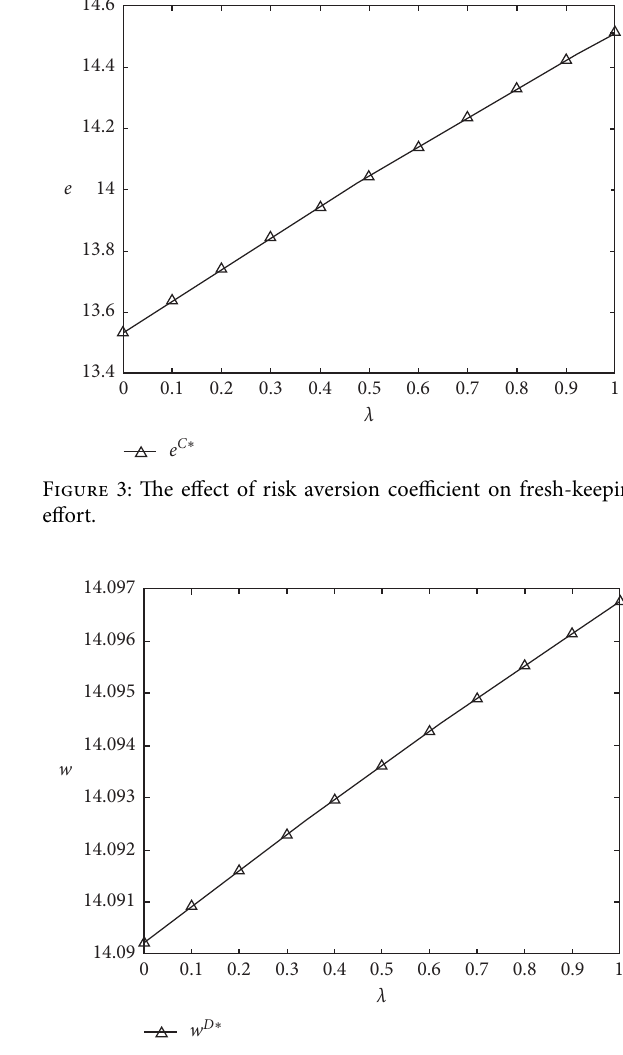
Figure 4: The effect of risk aversion coefficient on wholesale